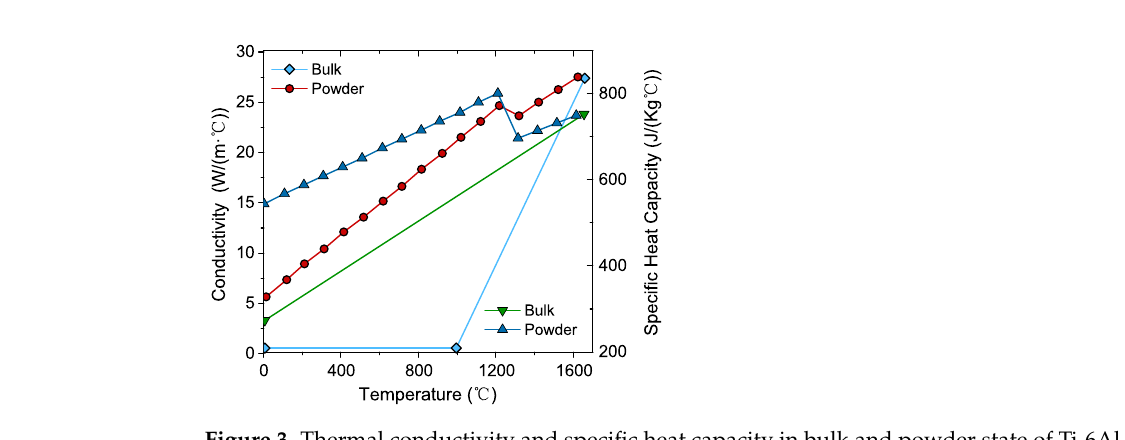
Figure 3. Thermal conductivity and specific heat capacity in bulk and powder state of Ti-6Al-4V. In the SLM process, materials often exist in three states: powder state, liquid state and solid state. The material is controlled by temperature and state changes occur due to the limitation of curing temperature and liquefaction temperature. In the present work, the relationship between the states of the materials and the temperature is established by using a USDFLD user-subroutine in the FE solver